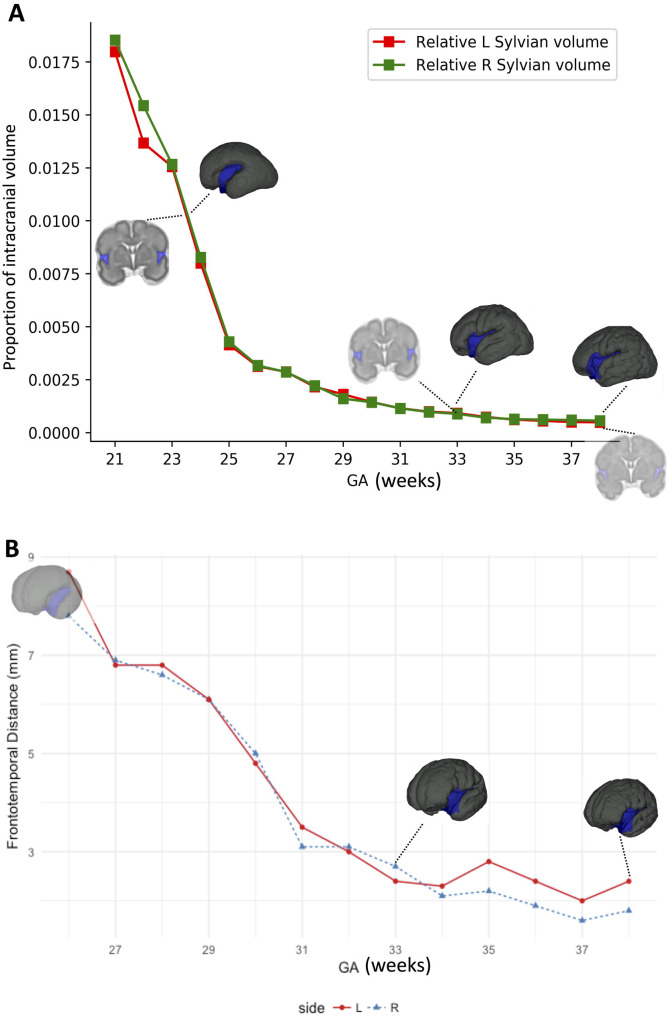
The relative volume of the Sylvian fissure contracts over time.(A) shows that the volume of the fissure (expressed as a proportion of the total intracranial volume) diminishes over time. A three-dimensional reconstruction and a coronal cut of the averaged MR images from the Gholipour atlas at weeks 24, 33 and 38 are depicted. The fissure volume is painted in light blue. (B) represents the absolute distance between the frontal and temporal lobes over time. The growth of these two lobes over the insula produces a graph in which the fronto-temporal distance diminishes over time, consistent with the relative volume contraction. These two lobes grow into each other and come in close contact only at the very end of gestation.